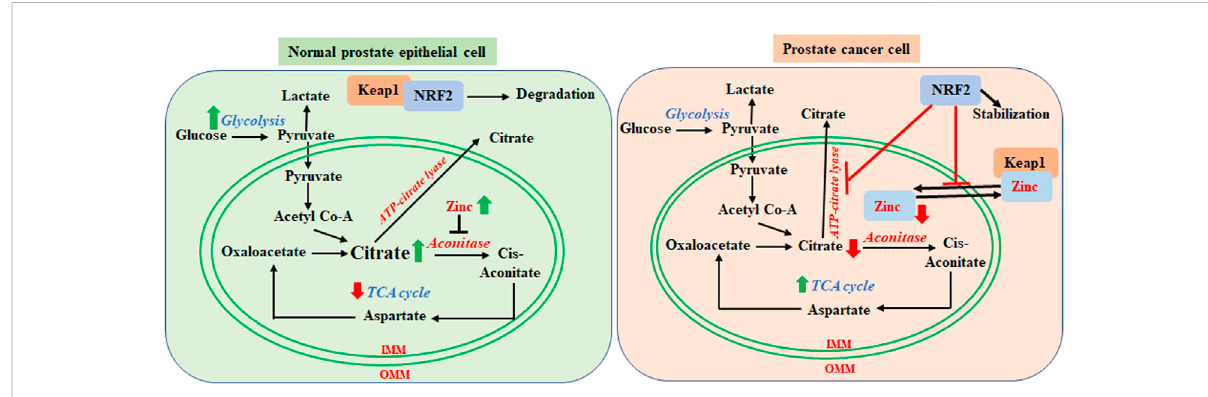
FIGURE 2 Regulatory role of NRF2 in metabolic switching from normal prostate cell to prostate cancer cells. In normal glycolytic prostate epithelial cells, mitochondriacontainhigherlevelsofzinc,whichinhibitsaconitaseactivity.Thisresultsintheaccumulationofcitrateinthemitochondriaandexport outside of mitochondria, which decrease TCA cycle-mediated energy generation. In the cytosol, Keap1 sequesters NRF2 for degradation. In the prostate cancer cells, zinc levels are lower in the mitochondria. Zinc translocates to the cytosol and competitively binds to Keap1, which releasesNRF2.StabilizedNRF2inhibitsmitochondrialimportofzincandATP-citratelyasemediatedcitratelysisandexport.Lowerzinclevelsenables mitochondrial aconitase to utilize citrate via the TCA cycle. Mitochondrial retention of citrate enables fatty acid synthesis by acetyl CoA. PCa cells hereby rely on the TCA cycle and fatty acids for energy generation in the more advanced